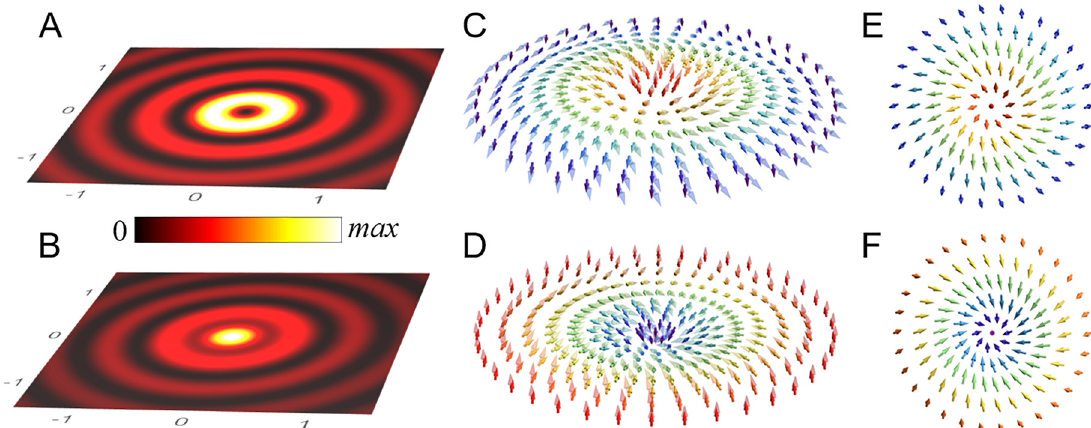
Figure 2: (A, B) Electric field profile of (A) TM polarized evanescent vortex induced by an electric Hertz vector potential and (B) TE polarized evanescent vortex induced by a magnetic Hertz vector potential, both with topological charge l = 1 in the absence of magnetization. (C) Distribution of the photonic spin orientation formed by the evanescent vortex beam with topological charge l = 1. The opaque arrows indicate the directionof the unit spinvector in(A), whilethe semitransparentarrows representthe modulatedspinvectors inthe presenceof the polar MO effect. (D) The same as (C) for a topological charge l = − 1. (E, F) Top view of the spin vectors in the presence of MO effect in (C) and (D), respectively.Theinplanewavevector( k r )oftheevanescentvortexforthesimulationsissetto1.012 k ,where k isthewavevectorinthemedium, and η is set to 0.3 + 0.03 i . In (A) and (B), x and y axis scales are normalized to the in-plane wavelength of the guided mode k r